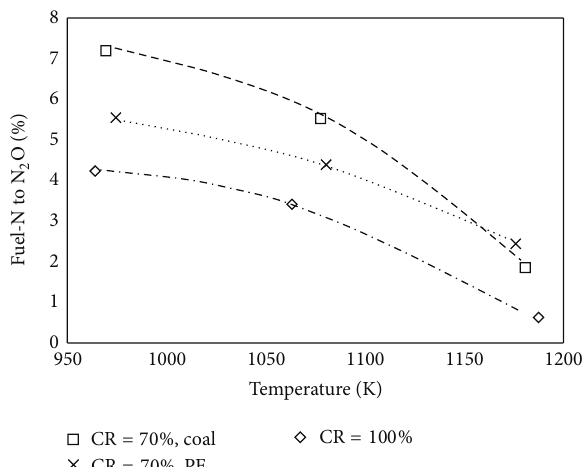
Figure 5: Influence of furnace temperatures on conversion ratio of fuel-N to NO.